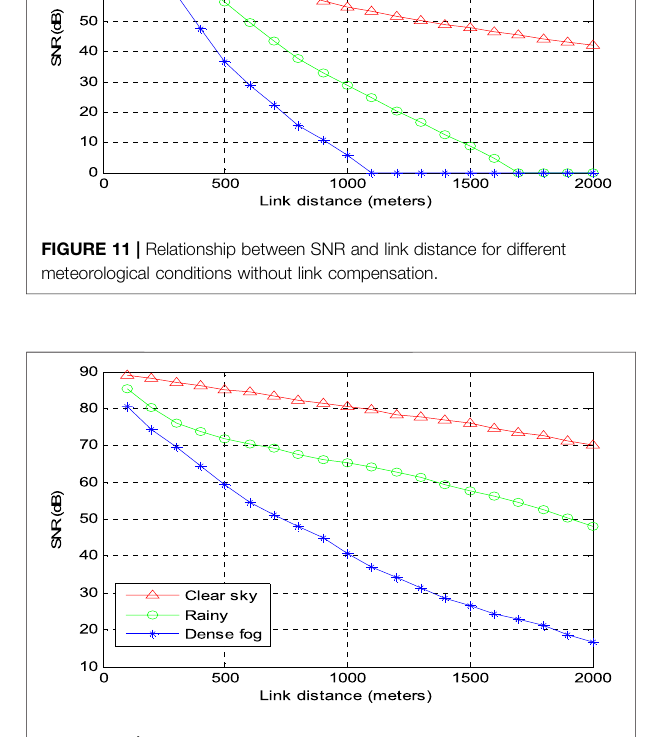
Figure 10 . As seen from Figure 10 , a consistently low BER pattern is observed for clear weather conditions for the entire link range of up to 2000 m. This is followed by a near similar performance under moderately adverse channel conditions.